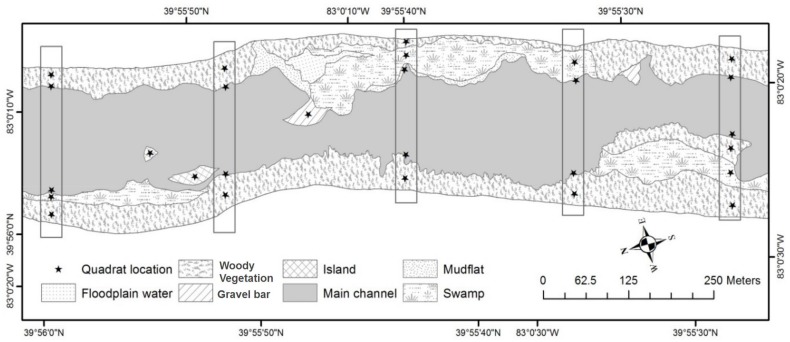
Experimental design.Example of experimental design at one of the study reaches including riverine landscape patches as well as transects and quadrats where ants were surveyed.